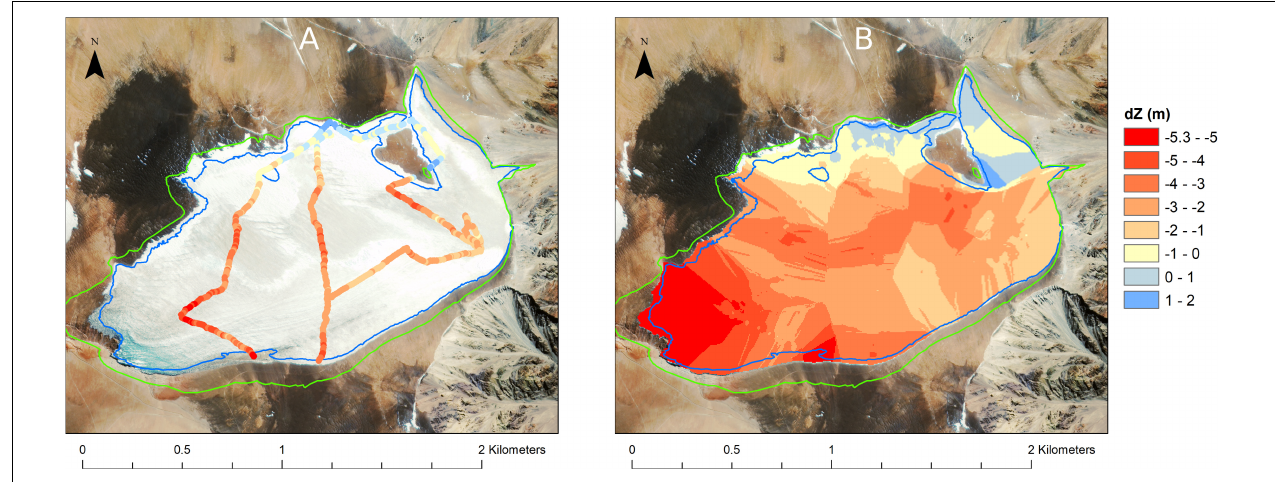
FIGURE 4 | Recent elevation changes on Guanaco Glacier, 2005–2011. (A) Satellite image of Guanaco Glacier (Ikonos, March 2005) showing DGPS tracks in October 2011 and measured elevation changes (dZ). Digitized glacier outlines in 1955 (green) and 2011 (blue) are shown. (B) Interpolated elevation changes using Ordinary